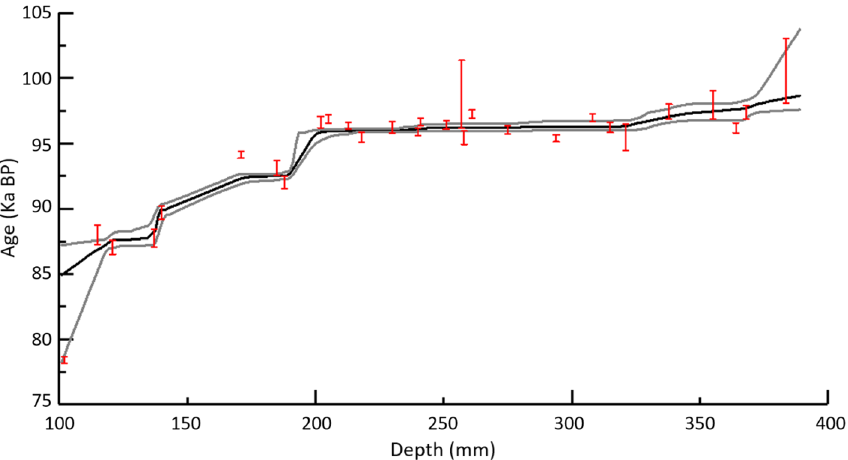
Figure 3. Chronological age-depth model developed for the stalagmite MCS-01 during MIS 5b based on StalAge Algorithm 36 . The grey lines represent the age model’s 95% confidence intervals. Age uncertainties of dated samples used in the age model are shown as well. Minor outliers shown in the age model we still considered as their uncertainty is increased using an iterative procedure by the StalAge Algorithm.